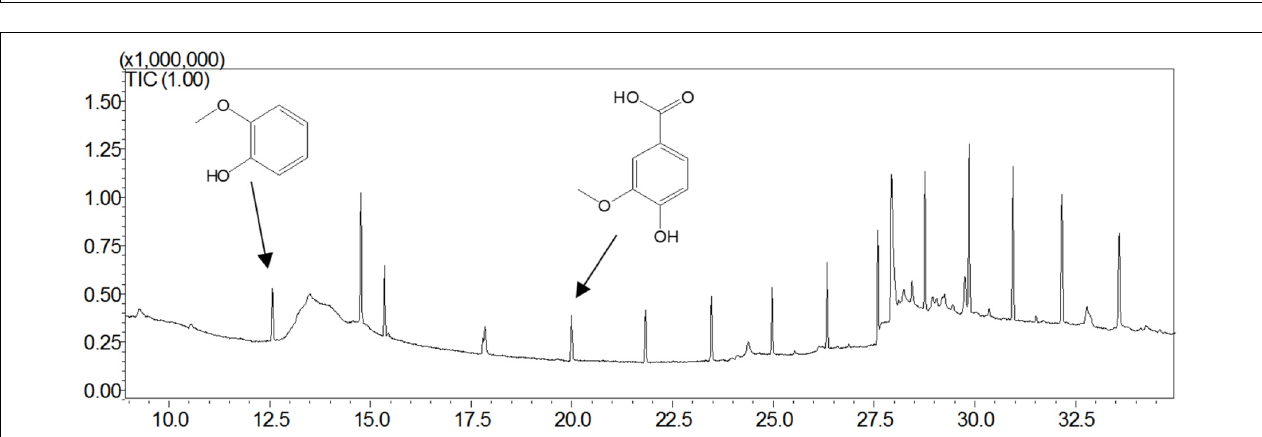
FIGURE 5 | The products analysis of lignin model compound GGE degraded by recombinant OhLac.